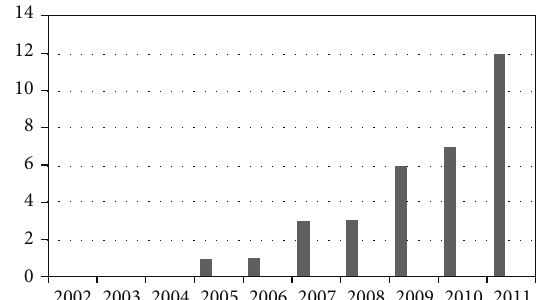
Figure 2: Number of children referred for fatigue symptoms (2002–